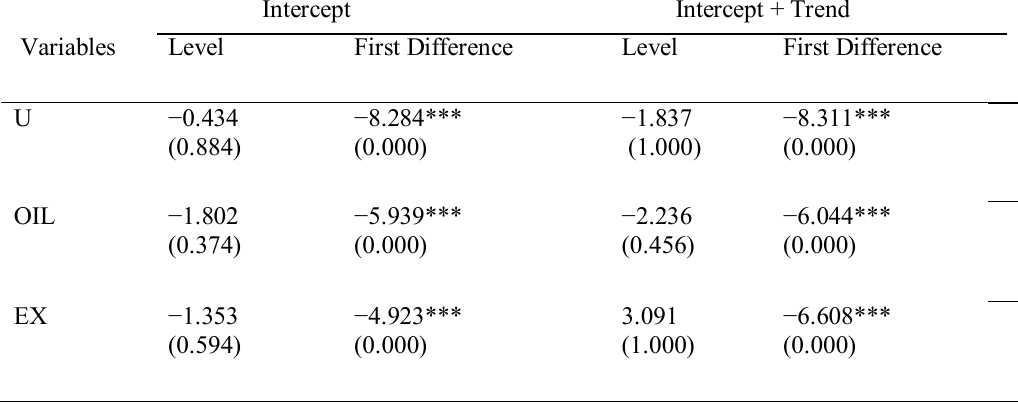
Table 1: ADF Unit Root Test Results